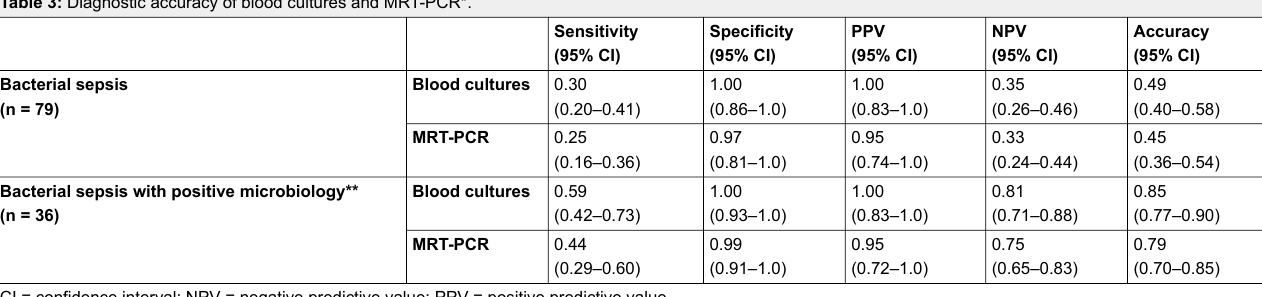
Table 3: Diagnostic accuracy of blood cultures and